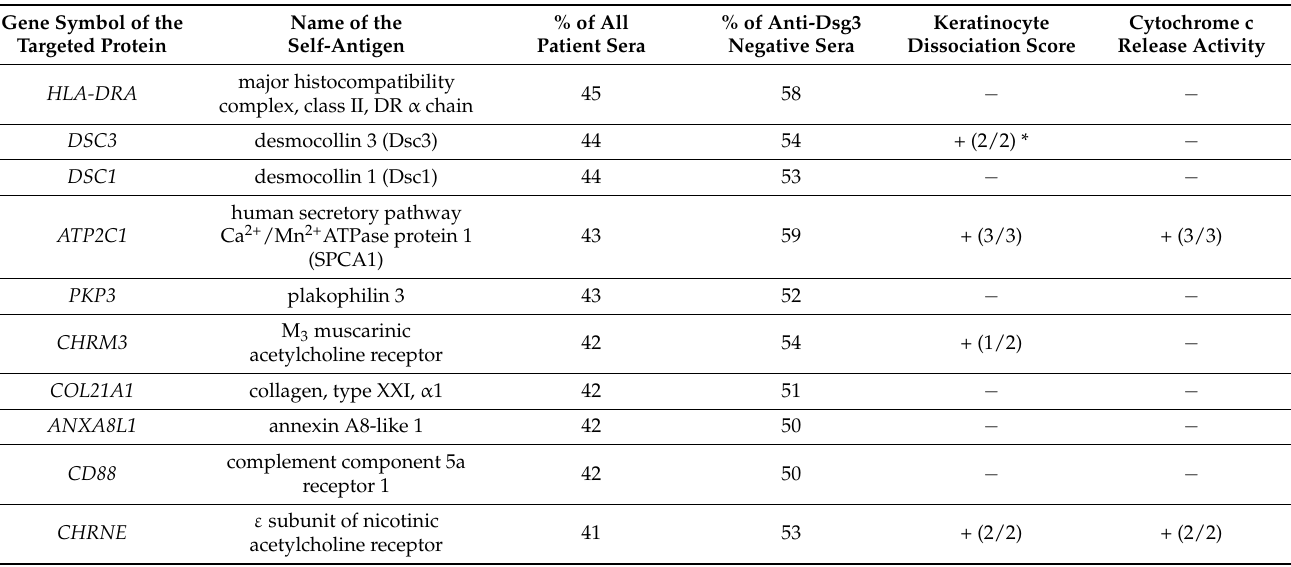
Table 2. Pathogenicity of top 10 non-Dsg autoantibodies immunoaffinity-purified from patients with acute